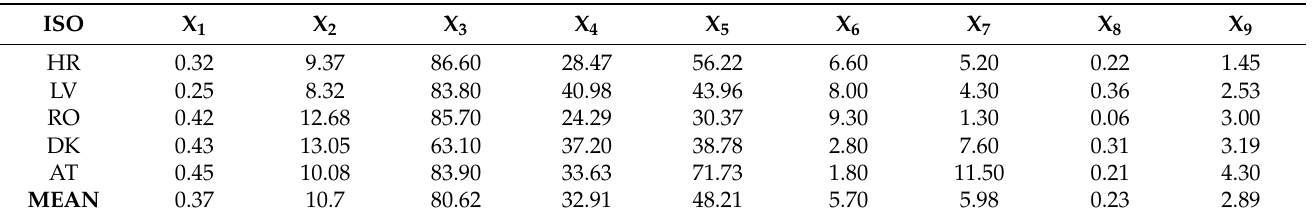
Table 6. “Smart and efficient energy systems”—values of diagnostic variables for countries constitut- ing cluster